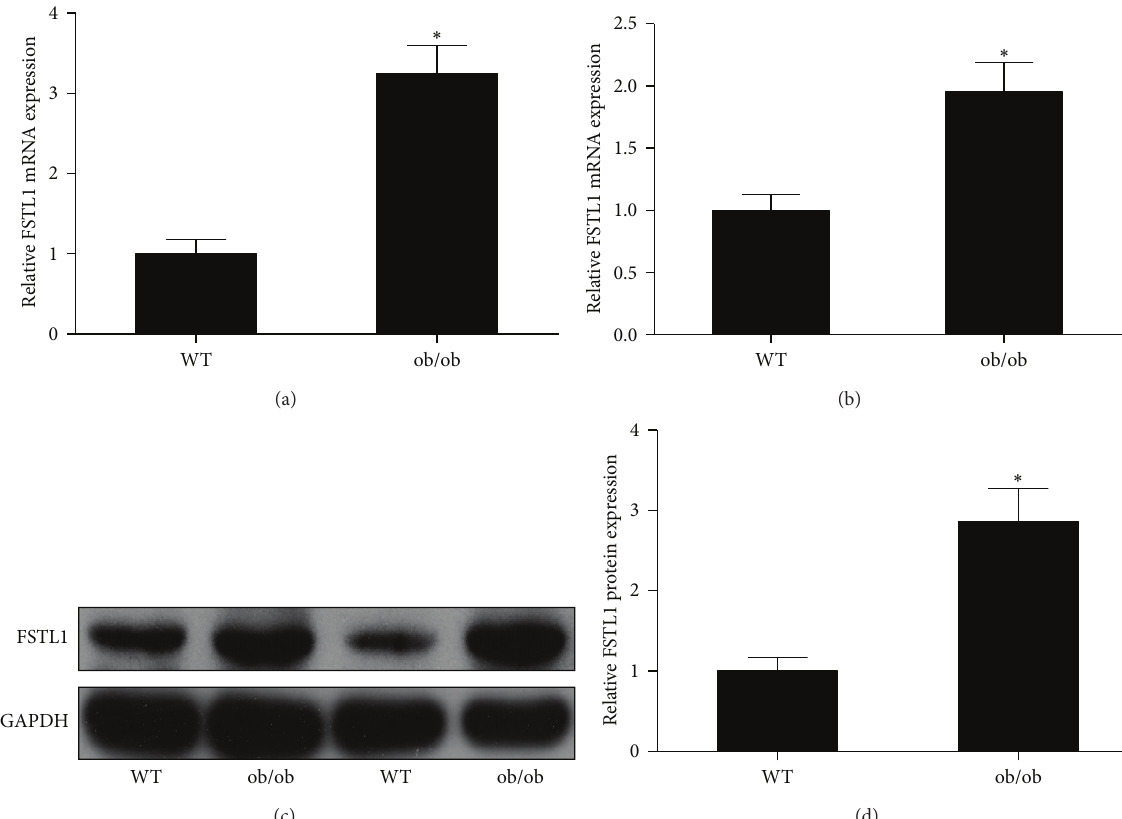
Figure 3: FSTL1 expression is increased in adipose tissue of obese mice. (a) and (b) Fstl1 mRNA expression was evaluated by quantitative RT-PCR in subcutaneous (a) and epididymal (b) adipose tissue of ob/ob mice and littermate controls ( 𝑛 = 10 per group). Relative mRNA expression was normalized to 𝛽 -actin and expressed as fold of controls. (c) Western blot analysis of FSTL1 protein expression in epididymal adipose tissue of ob/ob mice and littermate controls ( 𝑛 = 4 per group). (d) Intensity of bands was quantified by densitometry. Relative expression was normalized to GAPDH and expressed as fold of controls. ∗ 𝑃 < 0.05 versus control